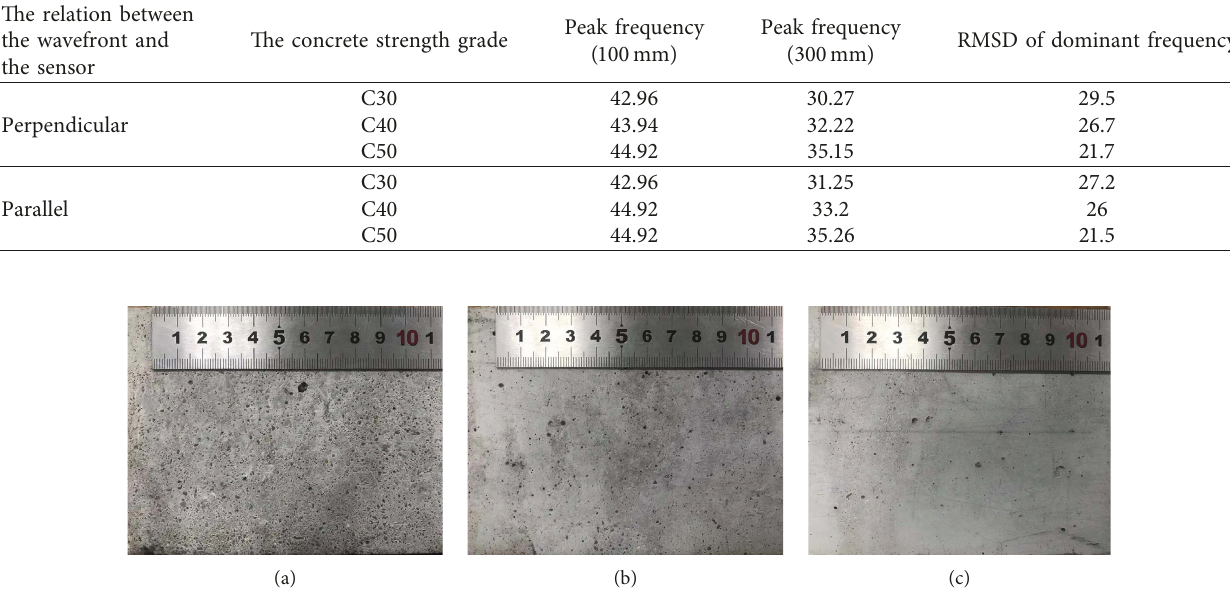
Figure 16: (a–c) Photos of concrete surfaces with different strength grades. (a) C30, (b) C40, and (c)